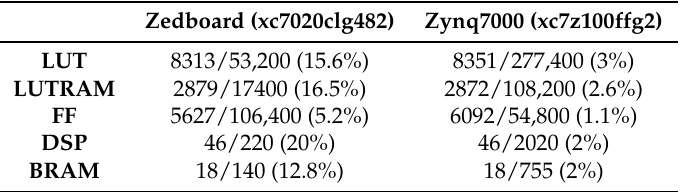
Table 1. PS + PL Resource Use for 16-bit